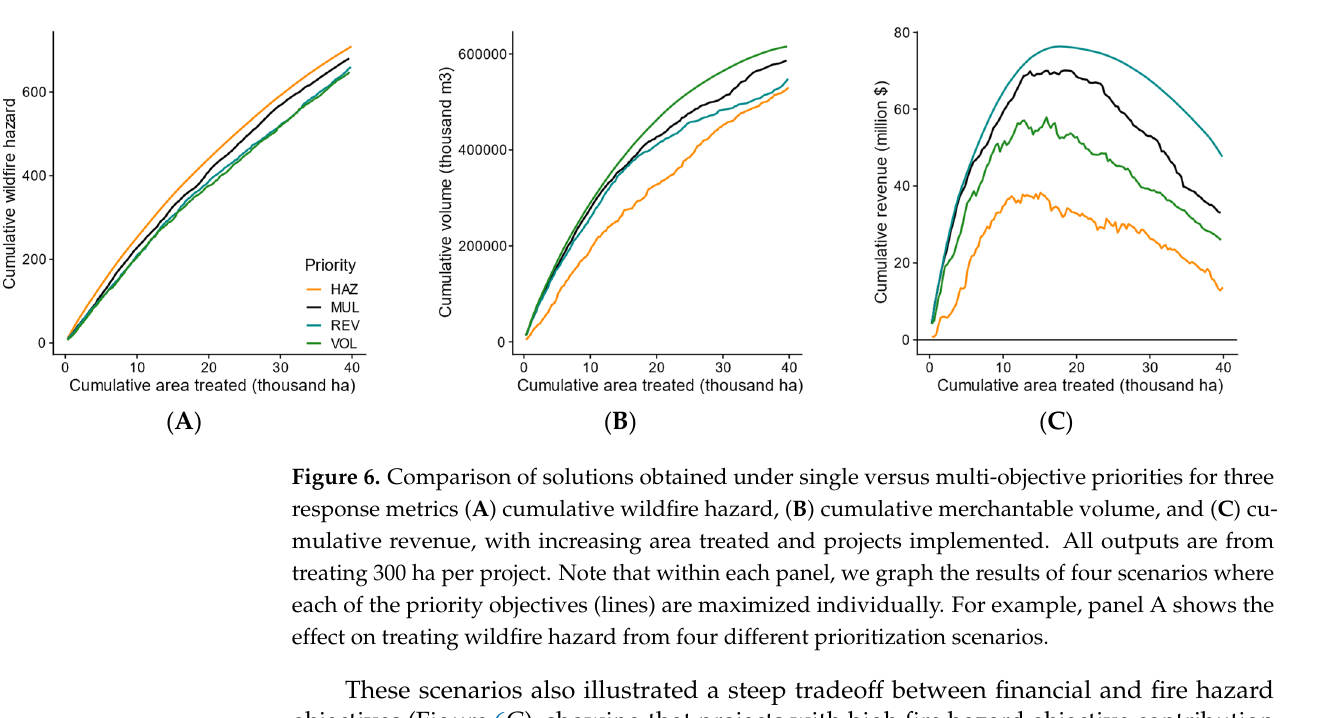
Figure 6. Comparison of solutions obtained under single versus multi ‐ objective priorities for three response metrics ( A ) cumulative wildfire hazard, ( B ) cumulative merchantable volume, and ( C ) cu ‐ mulative revenue, with increasing area treated and projects implemented. All outputs are from